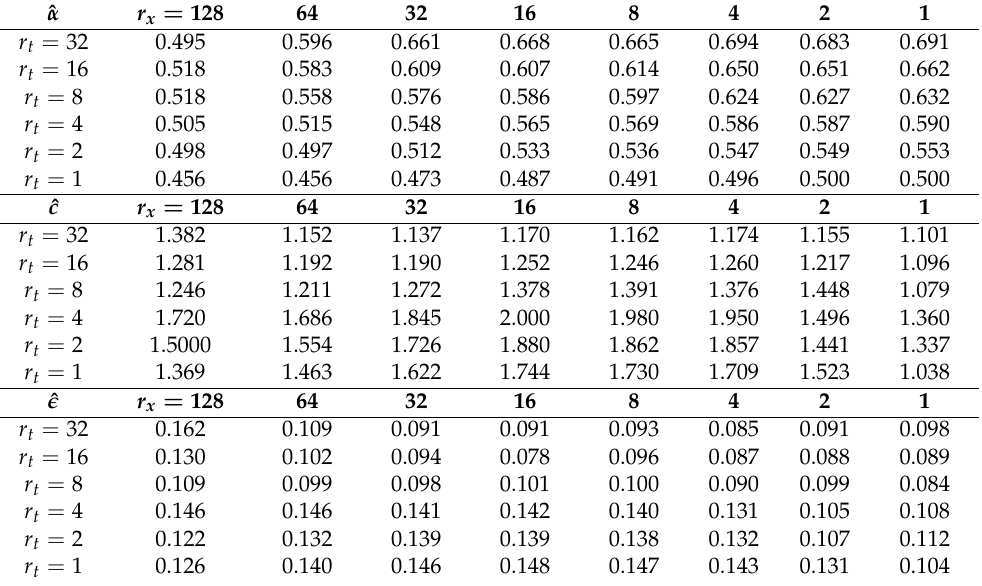
Table 3. Three-parameter estimation: Estimated ( α , c , (cid:101) ) from the full observation shown in the right panel of Figure 1. The effect of sparsity of observation on estimated parameters is demonstrated. The true parameters are α ∗ = 0.5, c ∗ = 1, and (cid:101) ∗ = 0.1. A quasi-Newton optimization algorithm, L-BFGS-B algorithm is employed to minimize the negative